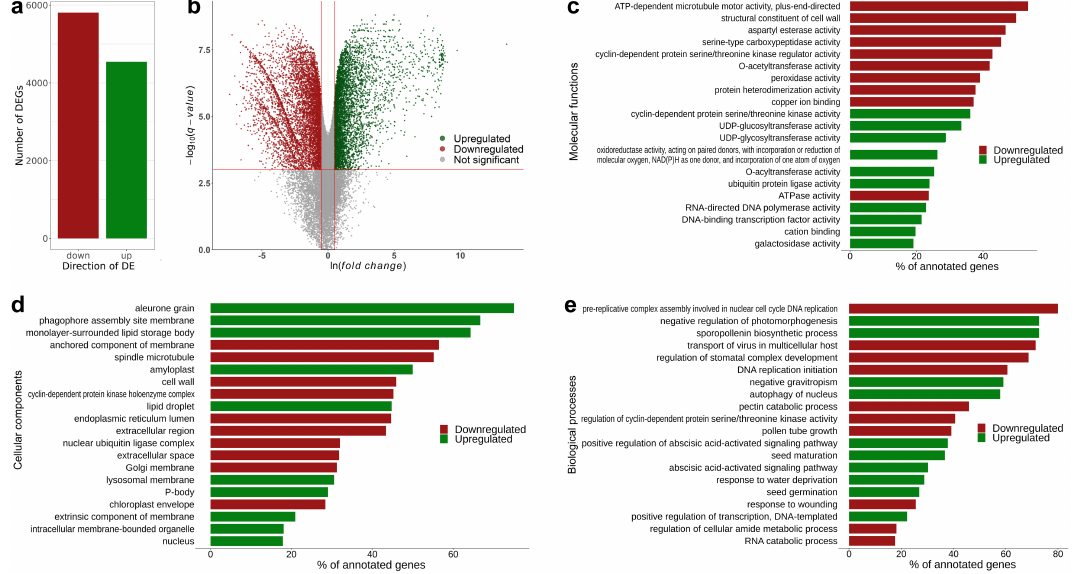
Figure 3. Transcriptomic changes in the transition from seed pre-maturation to seed filling stages in Sprint-2. ( a ) A total number of di ff erentially expressed transcripts at 20 DAP compared to 10 DAP seeds. ( b ) Volcano plots demonstrating di ff erentially expressed transcripts in 20 DAP seeds compared to 10 days after pollination (DAP) seeds. Plotted on the x -axis is the ln fold di ff erence between 10 DAP and 20 DAP seeds. Plotted on the y -axis is the − log 10 (q-value). Genes whose expression changes are nonsignificant are shown in gray below the red line, while significant di ff erentially expressed genes (FDR < 0.001) are divided into upregulated (green dots) and downregulated (red dots) genes. ( c – e ) Visualization of terms over-represented among di ff erentially expressed genes from Biological Process, Cellular Component, and Molecular Function aspects, respectively. The first ten categories have been chosen per aspect and arranged by the adjusted q-value. Bars are ranked according to the number of transcripts from the respective category being di ff erentially